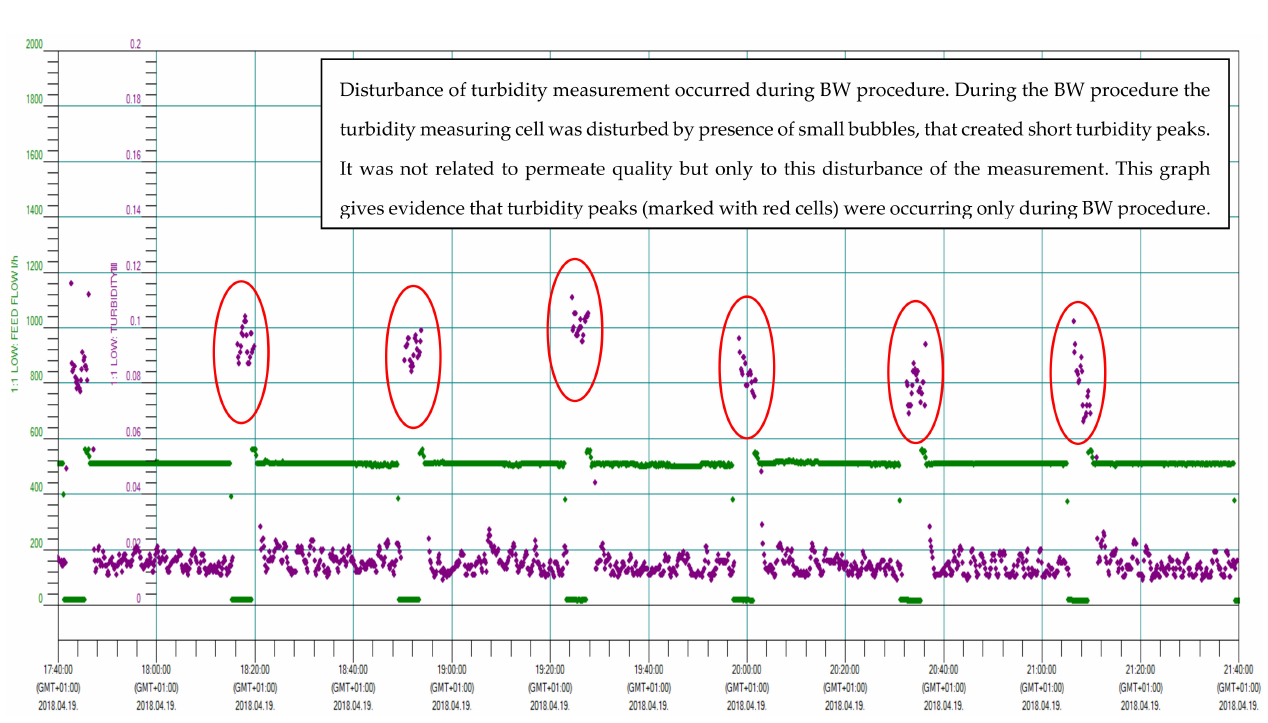
Figure A5. Flow and permeate turbidity (high resolution).